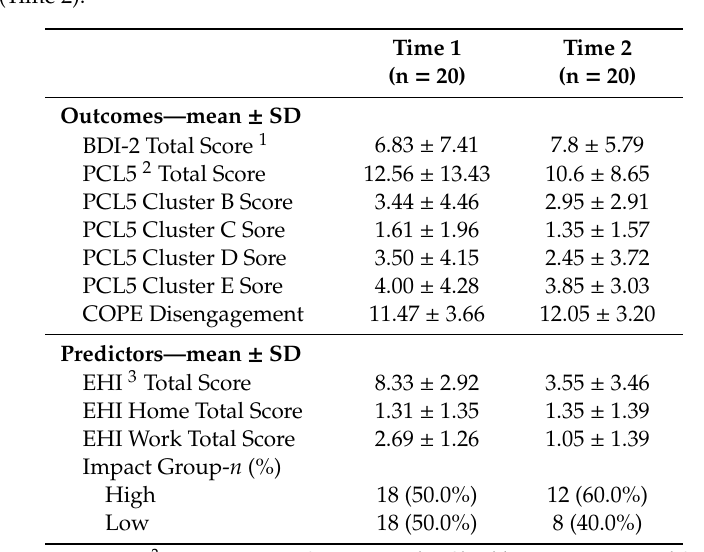
Table 2. Descriptive summary of study measures at for Extension Agents after 3 to 8 weeks (Time 1) and one year (Time 2).